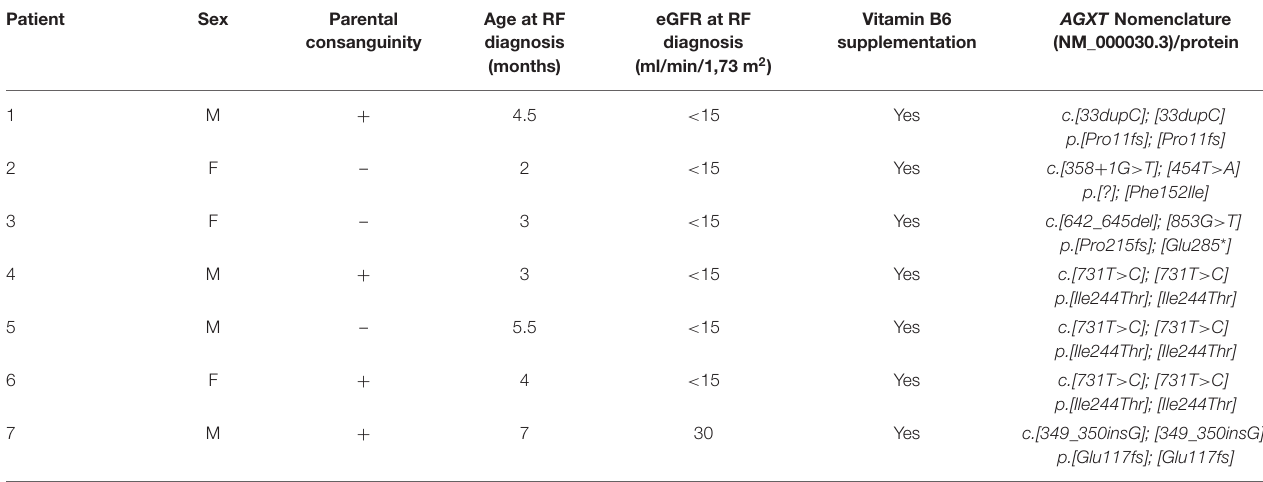
TABLE 1 | Characteristics of included patients.